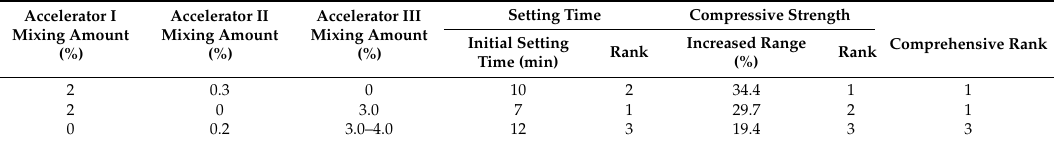
Table 2. Comparison on grouting effect under mixed use of